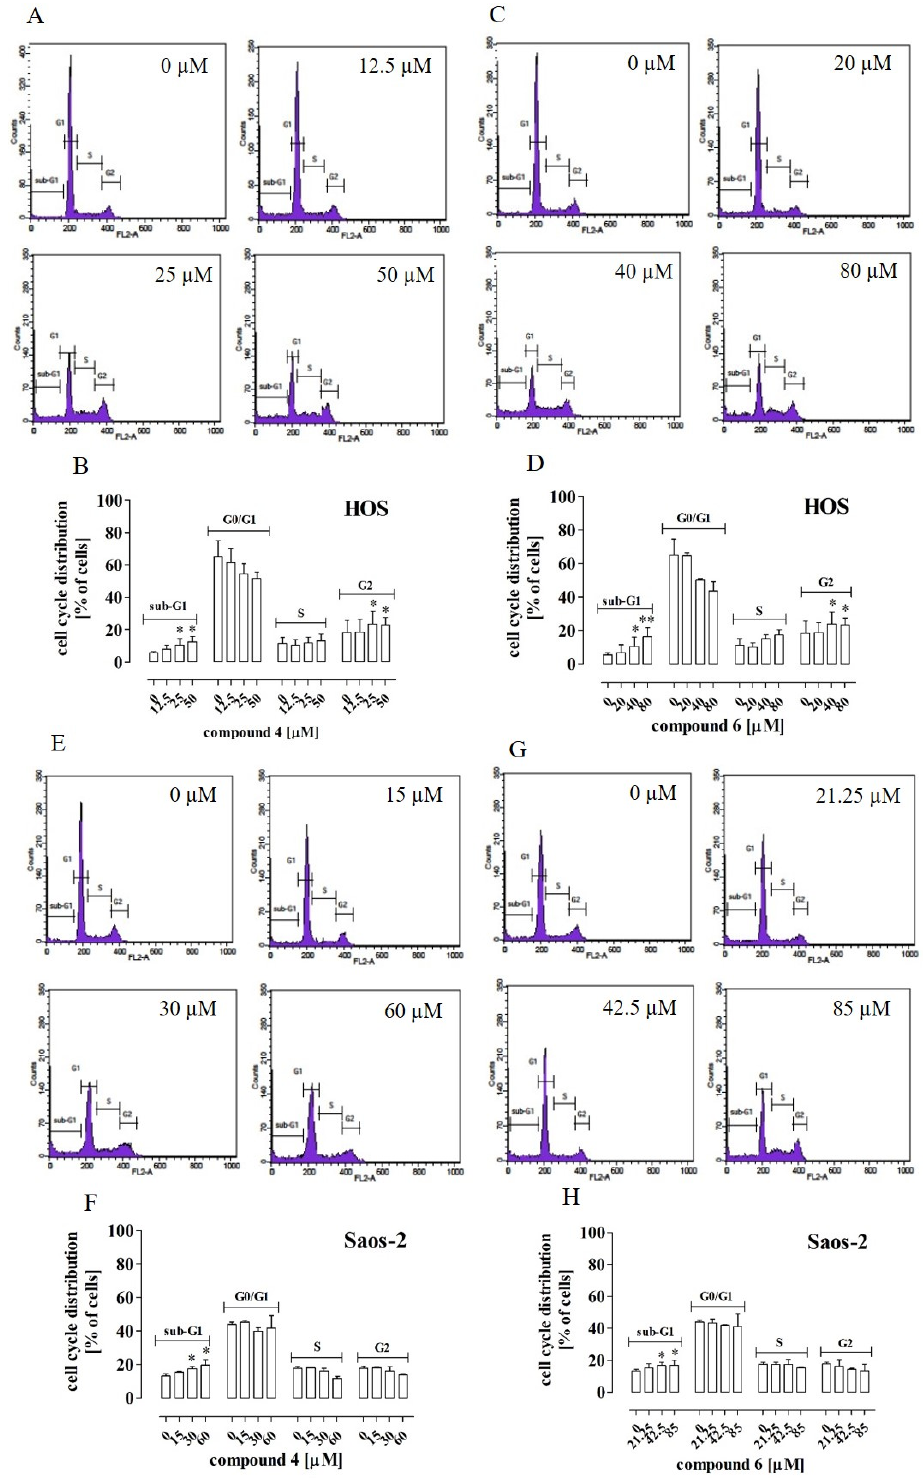
Figure 2. Effect of compounds 4 and 6 on cell cycle distribution in HOS and Saos-2 cells. The cells were treated with the compounds at the indicated concentrations for 72 h. The histograms are representative (HOS–( A , C ); Saos-2–( E , G )) and correspond with the percentage of cells at each cell cycle phase (HOS—( B , D ); Saos-2—( F , H )) determined by flow cytometry after cell staining with PI/Rnase. The results are mean values ± SD of at least three independent experiments.Statistically significant differences: *—at p < 0.05; **—at p < 0.01 in comparison with the untreated cells (one-way ANOVA followed by Dunnett’s post-hoc